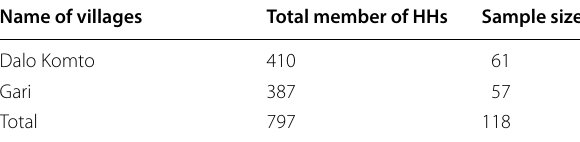
Table 1 Selected household unity of the study